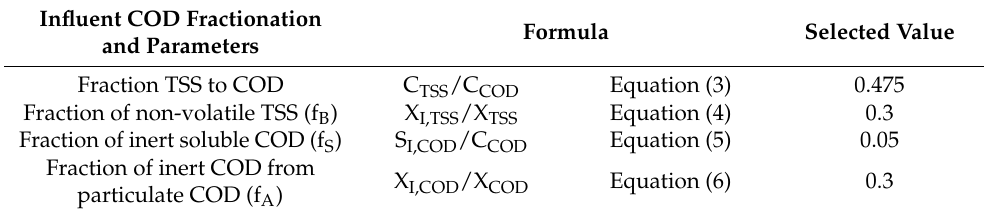
Table 4. Selected influent parameters.